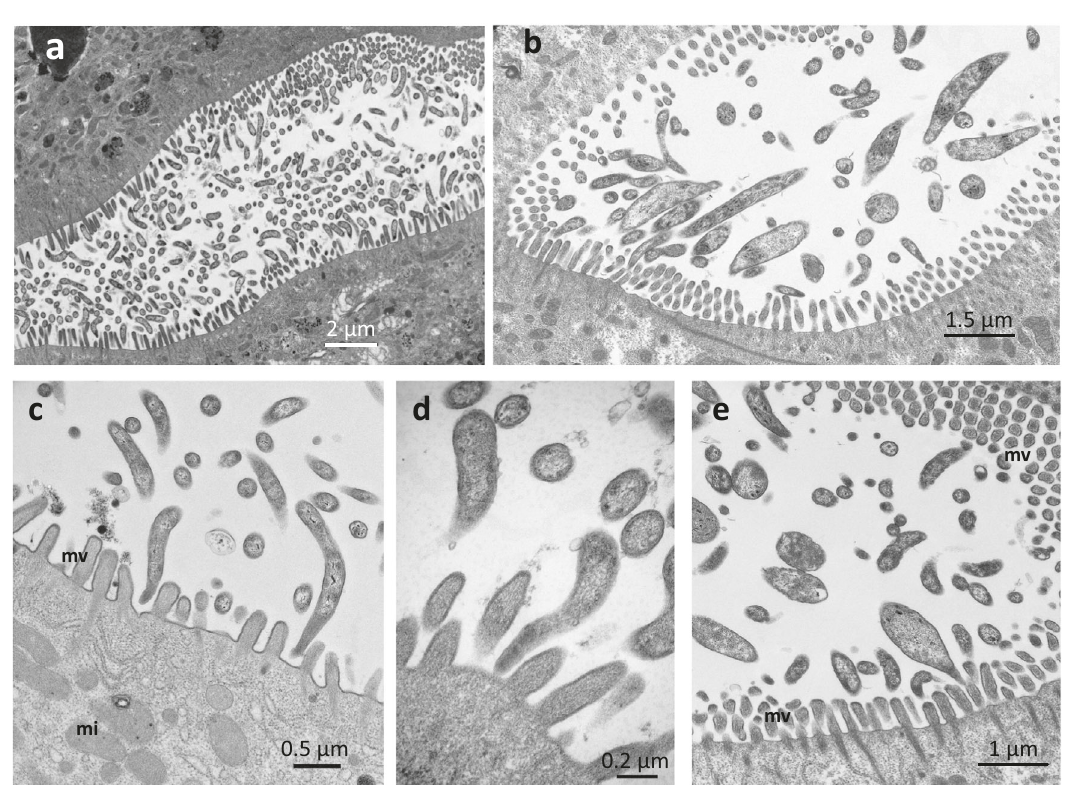
Fig. 1 Extracellular bacteria in the midgut glands of terrestrial isopods positive for Hepatincola . TEM micrographs of extracellular bacteria in the midgut glands of P. pruinosus ( a , c , d ) and O. planum ( b , e ). a , b Large views showing dense bacterial populations in the lumen of the midgut glands of P. pruinosus ( a ) and O. planum ( b ), often in close vicinity to the midgut epithelium ( b ). The bacteria often form stalk-like protrusions at one cell pole, which is inserted between the microvilli of the epithelium ( c – e ). mi mitochondrion, mv microvilli. Scale bars: a = 2 µm, b = 1.5 µm, c = 500 nm, d = 200 nm, e = 1